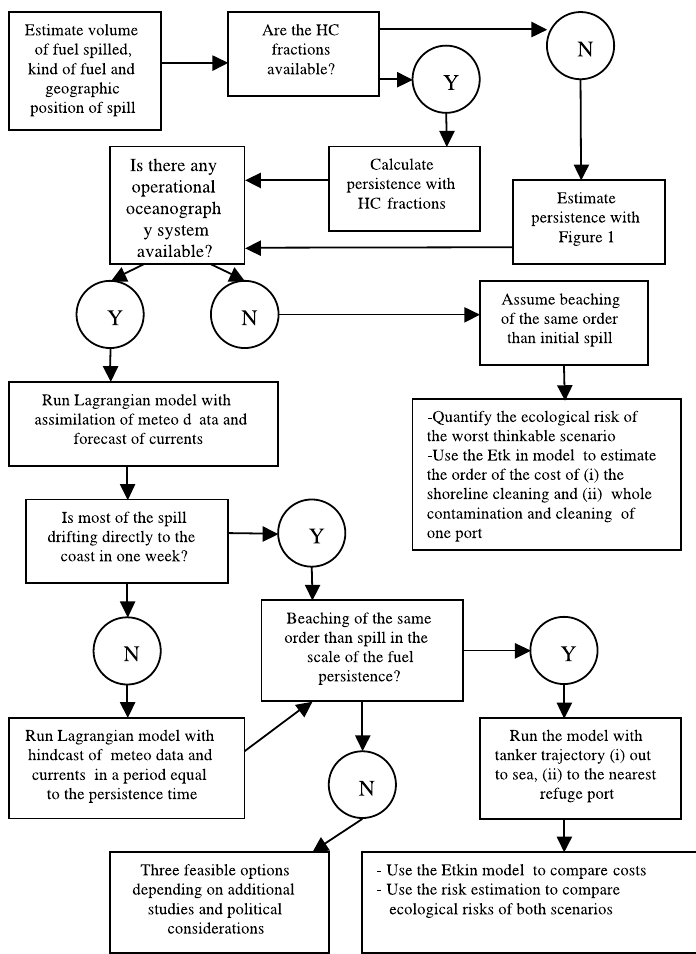
Fig . 8. – Decision Tree for an accident off the Galician